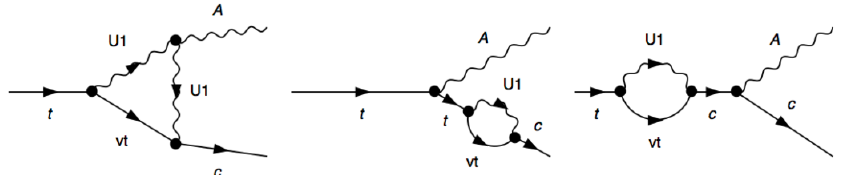
Figure 2 . One-loop top FCNC decays of t scalar LQ S 1 .